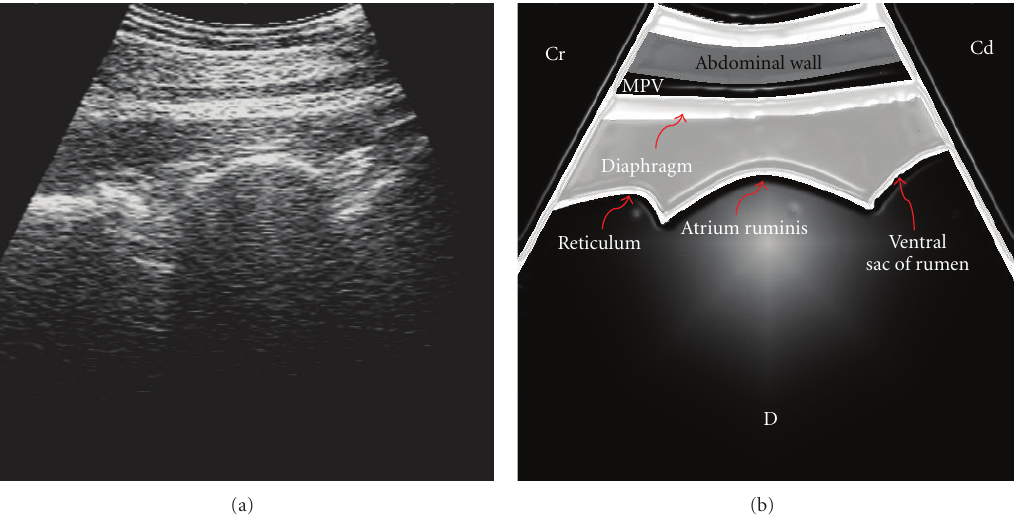
Figure 3: Ultrasonogram of the reticulum, atrium ruminis, and ventral sac of the rumen imaged from the left paramedian side, by placing the transducer parallel to the longitudinal axis of the cow. MPV: musculophrenic vein, Cr: Cranial, Cd: caudal, and D: dorsal.